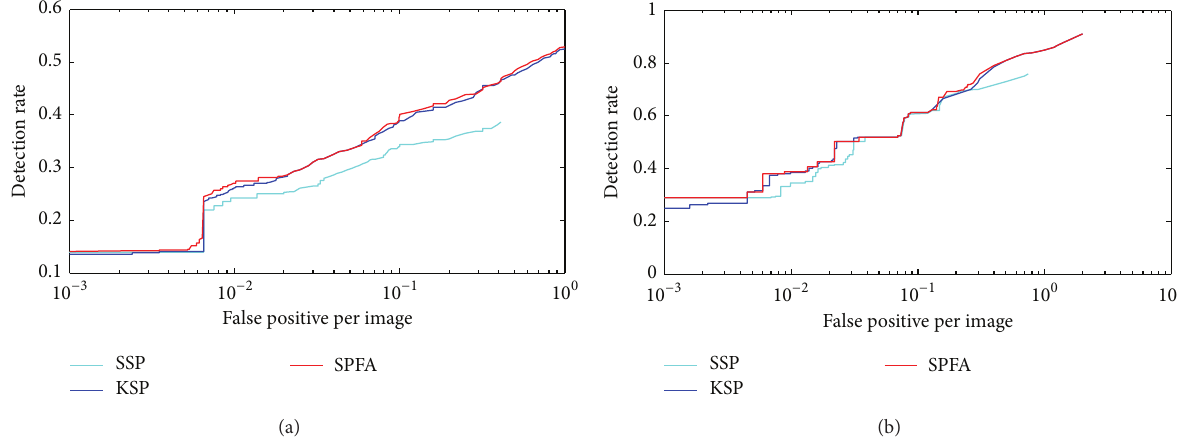
Figure 12: Detection rate versus false positive image on Sequence3 of the BEHAVEDATA dataset (a) and Seq03view1 of the ETHMS dataset (b).